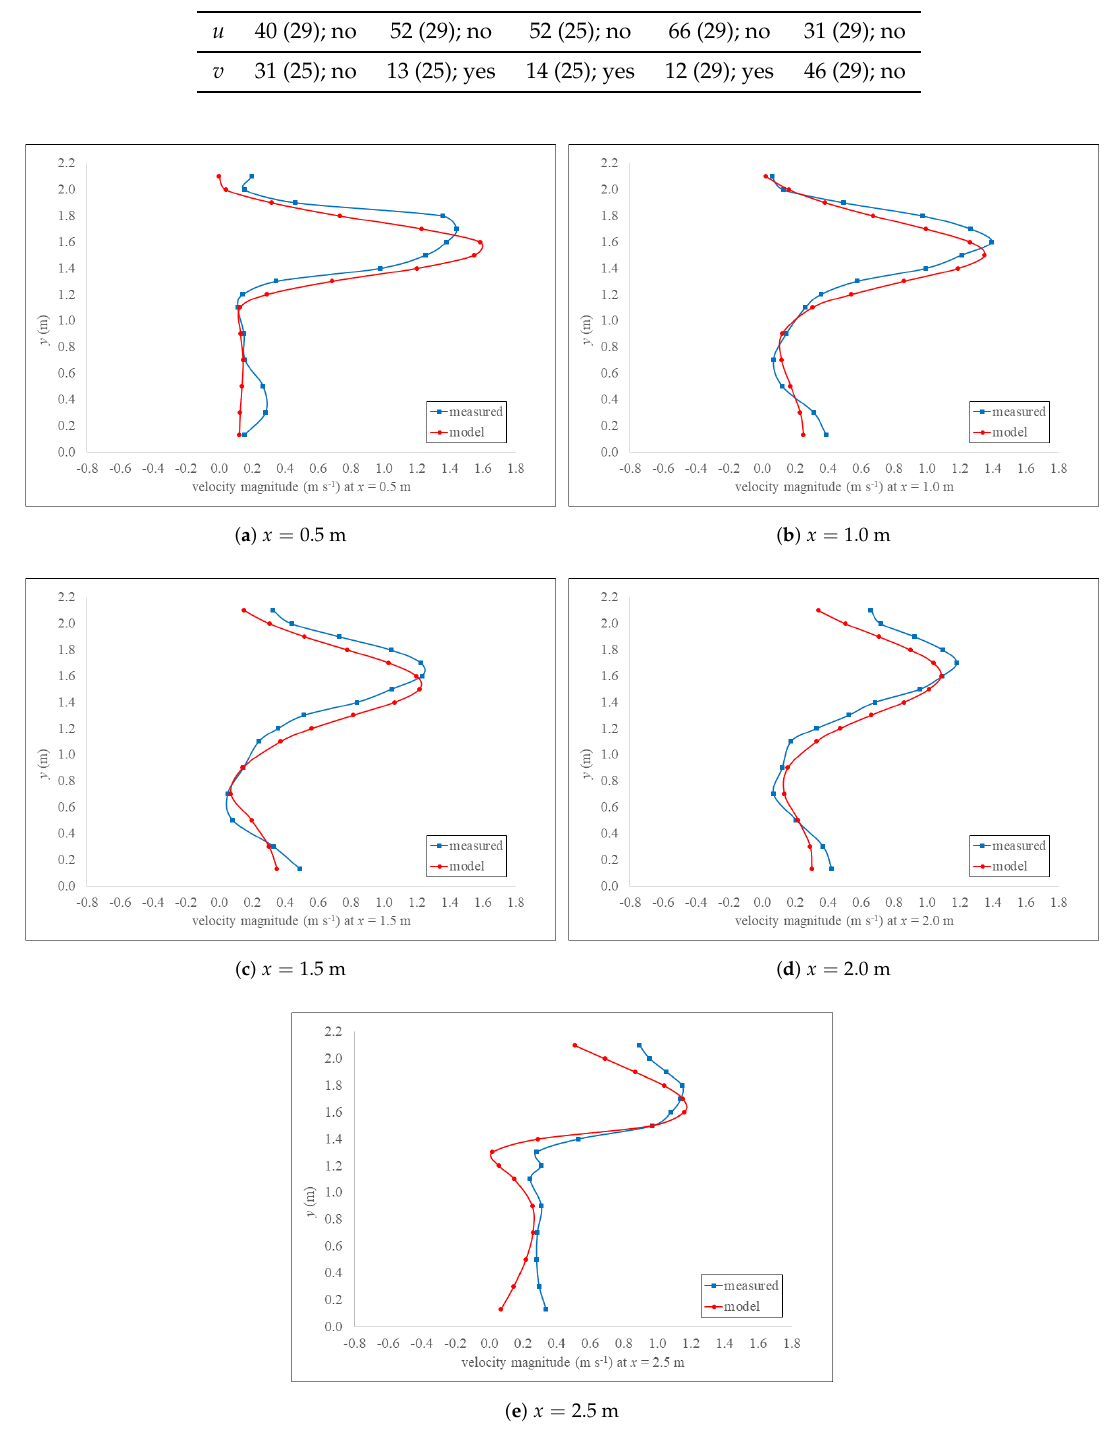
Figure 9. Velocity magnitude against vertical distance at different x locations. Red curves with circles are SPH velocities, blue curves with squares are experimental